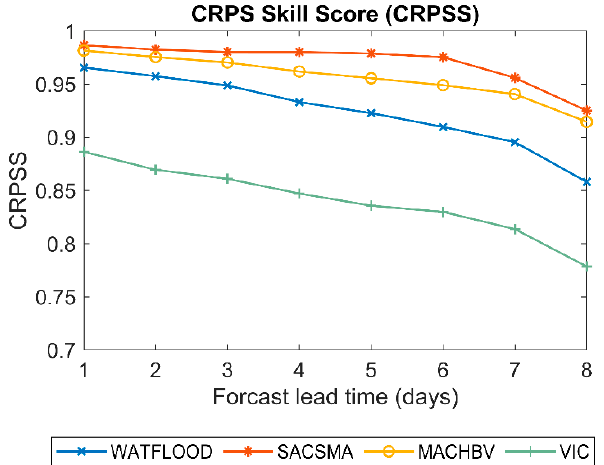
Figure 7. Comparison of reservoir inflow ensembles between four hydrological models using CRPS skill score ( CRPSS